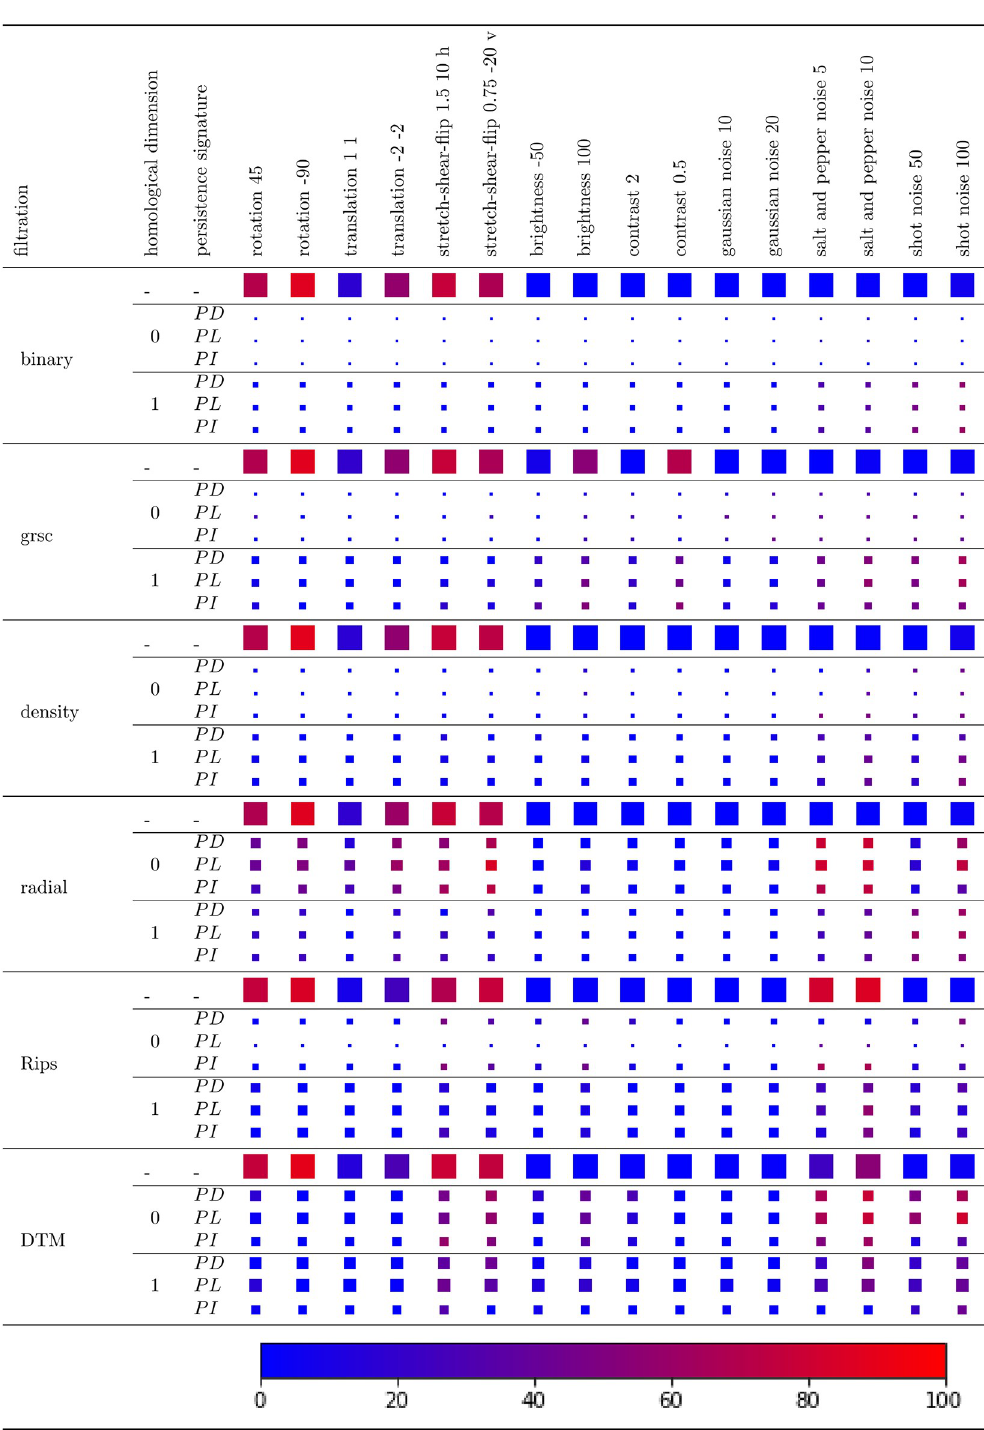
Fig 7. Noise robustness and discriminative power of persistent homology on 1000 MNIST greyscale images. The figure shows the drop in SVM classification accuracy when the test dataset is noisy, compared to the non-noisy test set, averaged across 1000 images in the MNIST dataset. Each image is represented either with its filtration function values (1st row of each filtration), or with its 0- or 1-dimensional persistence diagram (2nd and 5th row), persistent landscape (3rd and 6th row) or persistent image (4th and 7th row). The size of the node reflects the absolute accuracy on the non-noisy test data. The colour of the node reflects the accuracy drop, indicated in the colour bar. In particular, the presence of red nodes for PH information (2nd to 7th row) implies that PH is not robust under any type of noise, for any filtration and persistence signature.